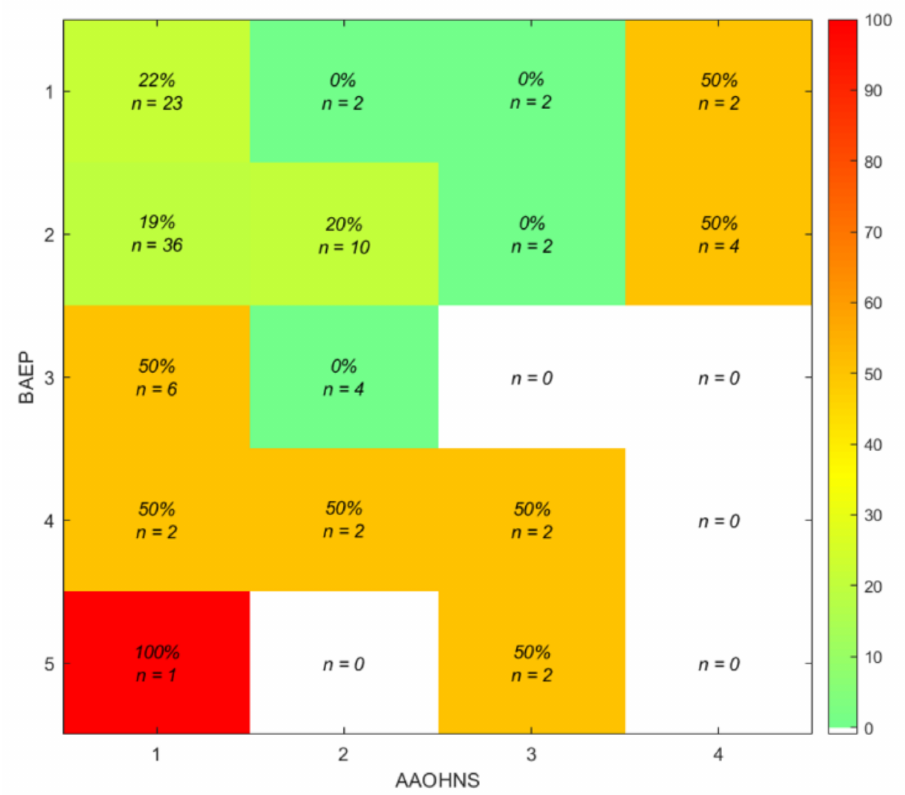
Figure 2. Relative risk prediction of postoperative hearing loss with preoperative BAEP and AAO– HNS